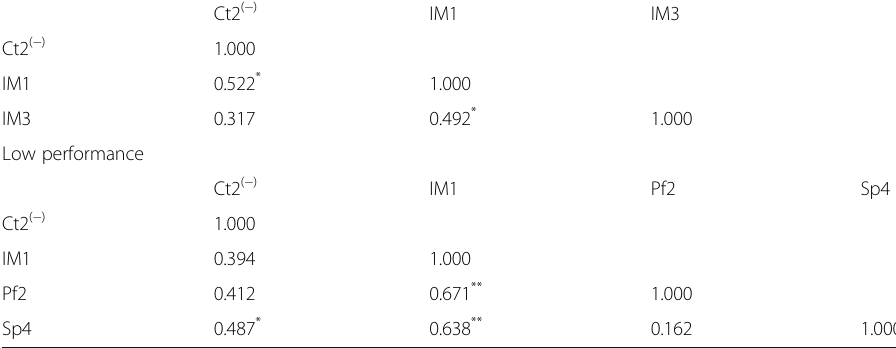
Table 5 Correlation between the variables encircled in Fig.